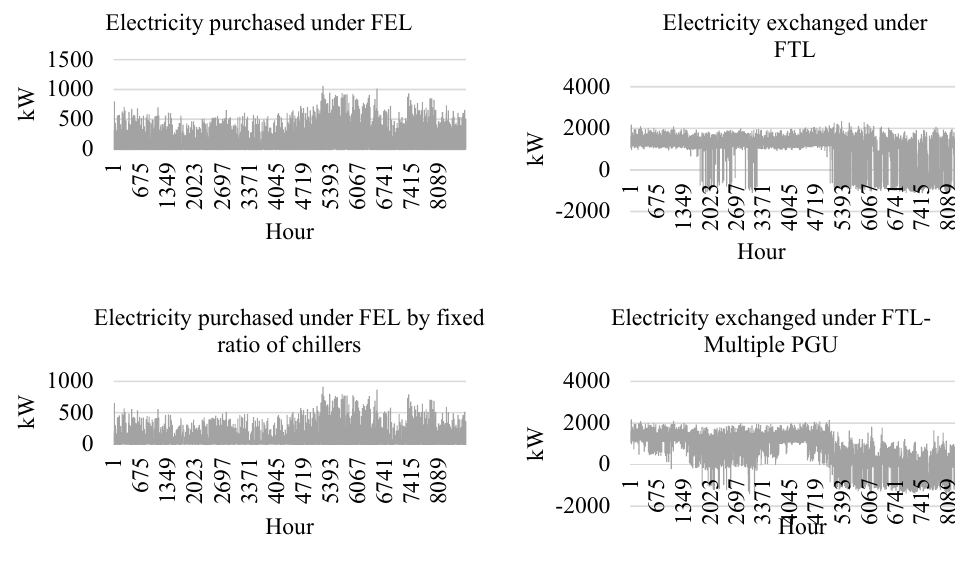
Fig. 11 . Electricity exchanged with the